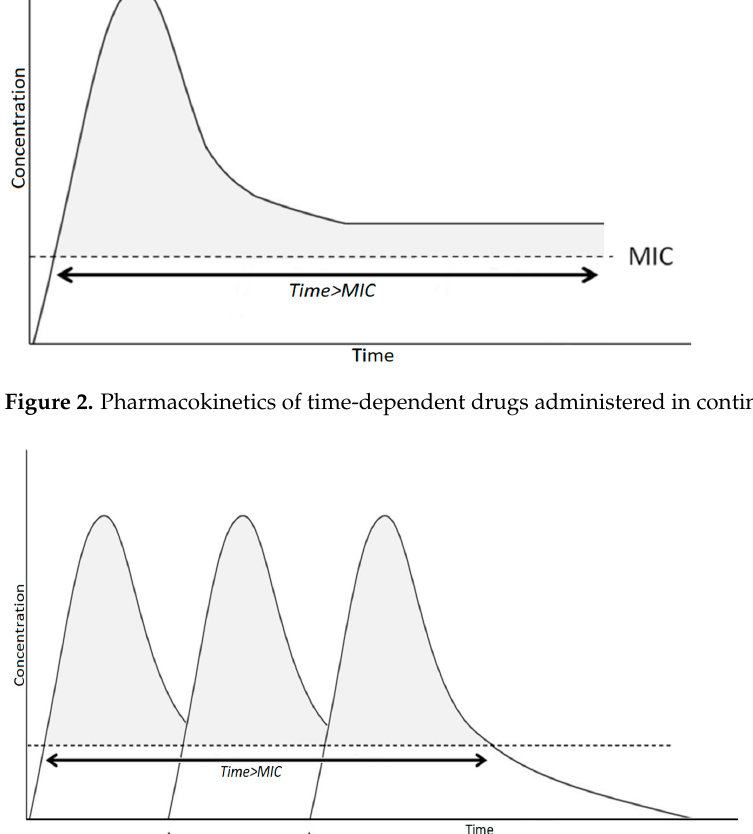
Figure 3. Time-dependent antimicrobial pharmacokinetic in intermi tt ent administration. Antimicro- bial e ffi cacy is determined by the time above MIC (T > MIC) of plasmatic unbound drug concentra- tion. Arrows shows the time of administrations.